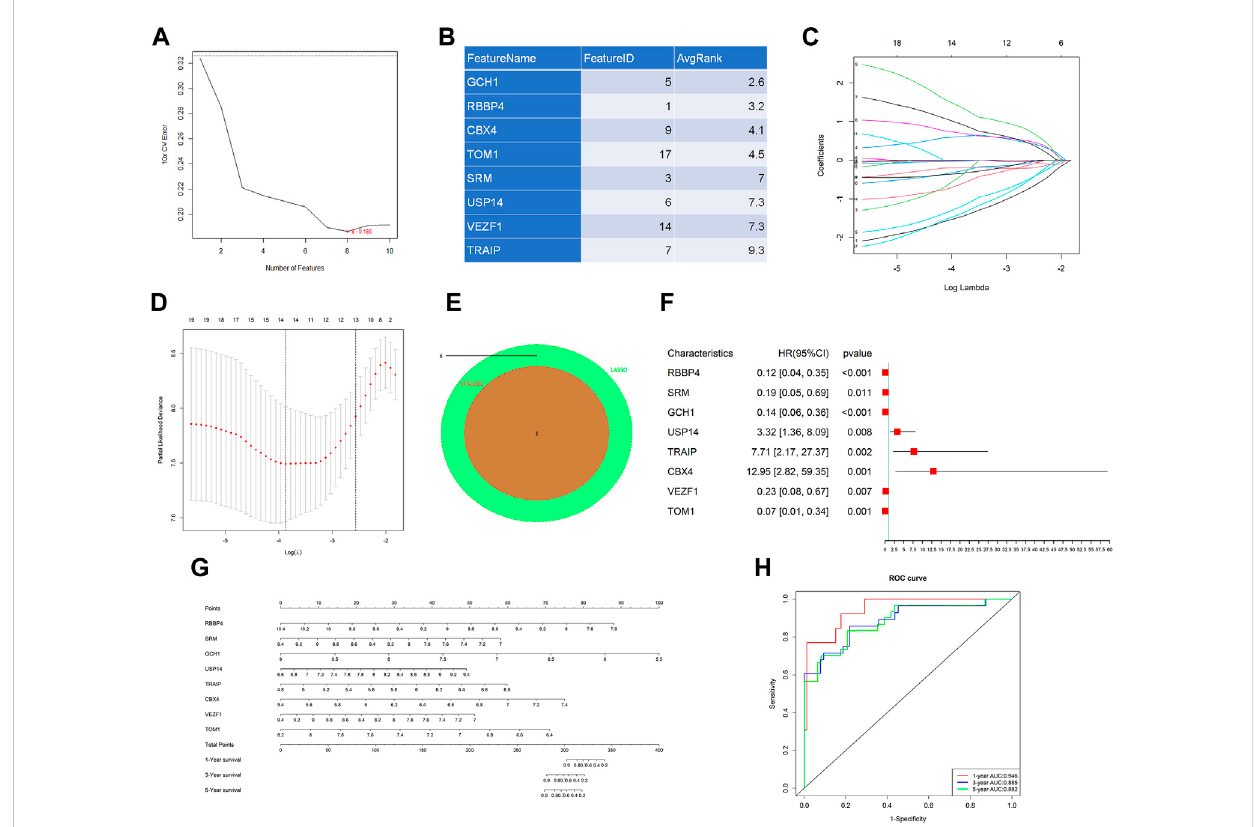
FIGURE 2 Machine learning analysis and establishmentof aprognosticmodel. Twoalgorithms wereused for feature selection: SVM-RFE (A and B) and LASSO (C and D) algorithms. (E) Intersection of two algorithms. (F) Forest plot of multivariate Cox regression analysis by eight hub genes. (G) Nomogram of the gene signature for predicting patient survival. (H) ROC curves of the gene signature on 1-, 3-, and 5-year OS in the